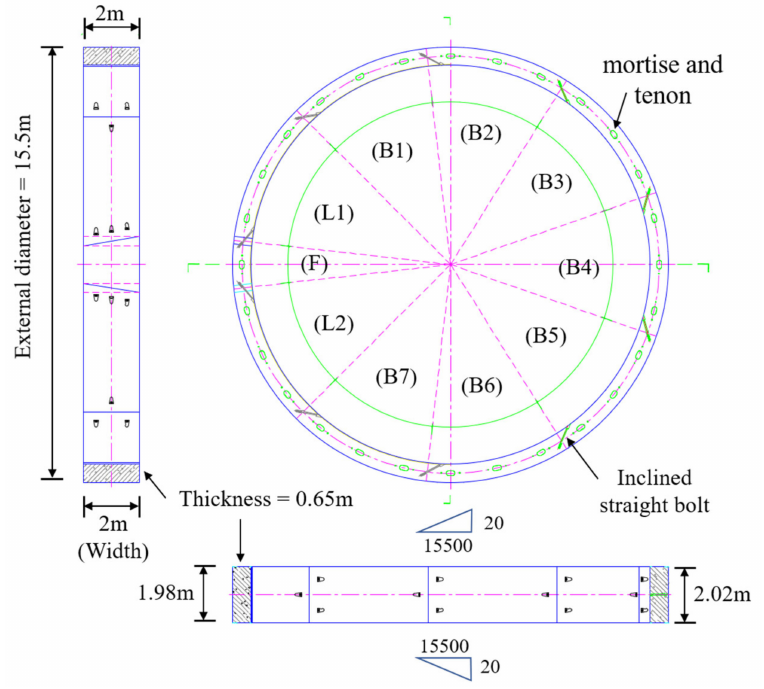
Figure 2. Segment layout and